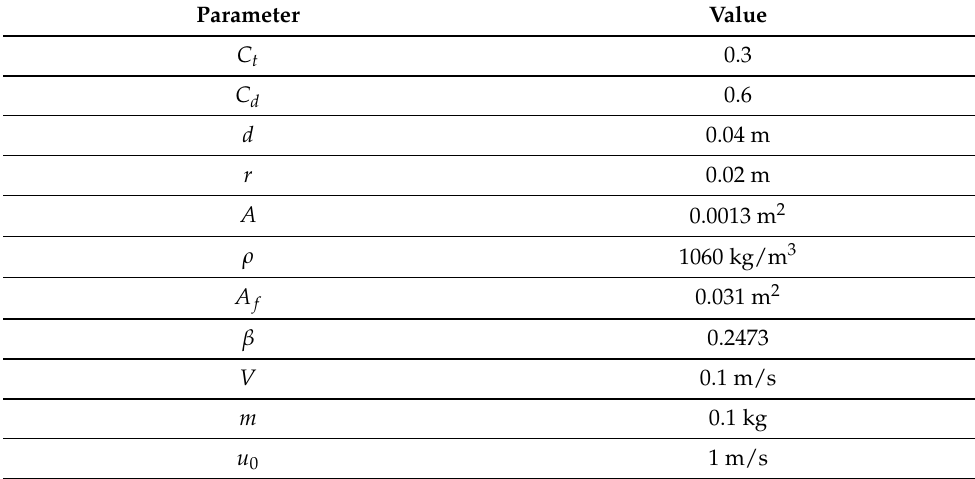
Table 1. Analytic Newtonian motion design